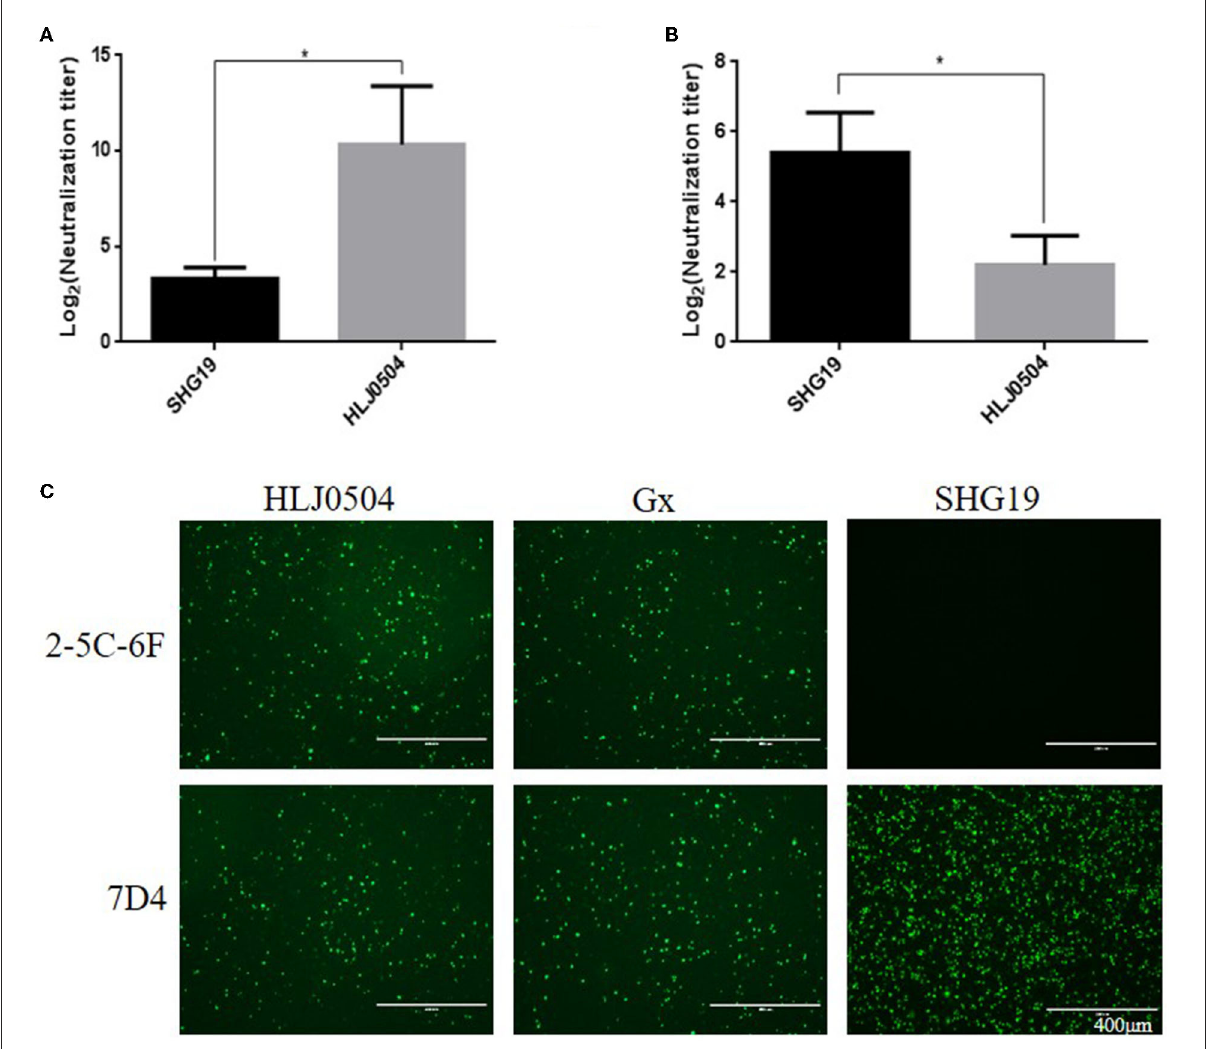
FIGURE1 Detection of antigenicity difference between the epizootic varIBDV (SHG19 strain) and vvIBDV (HLJ0504 strain and Gx strain). (A) Cross-neutralizing assay of HLJ0504 antiserum for SHG19 and HLJ0504 on DT40 cells directed. (B) Cross-neutralizing assay of SHG19 antiserum for SHG19 and HLJ0504 on DT40 cells directed. (C) IFA on DT40 cells directed by MAbs 2-5C-6F and 7D4. The mean titers and standard deviations (error bars) from three (A) or five (B) independent samples are shown. * represents p <